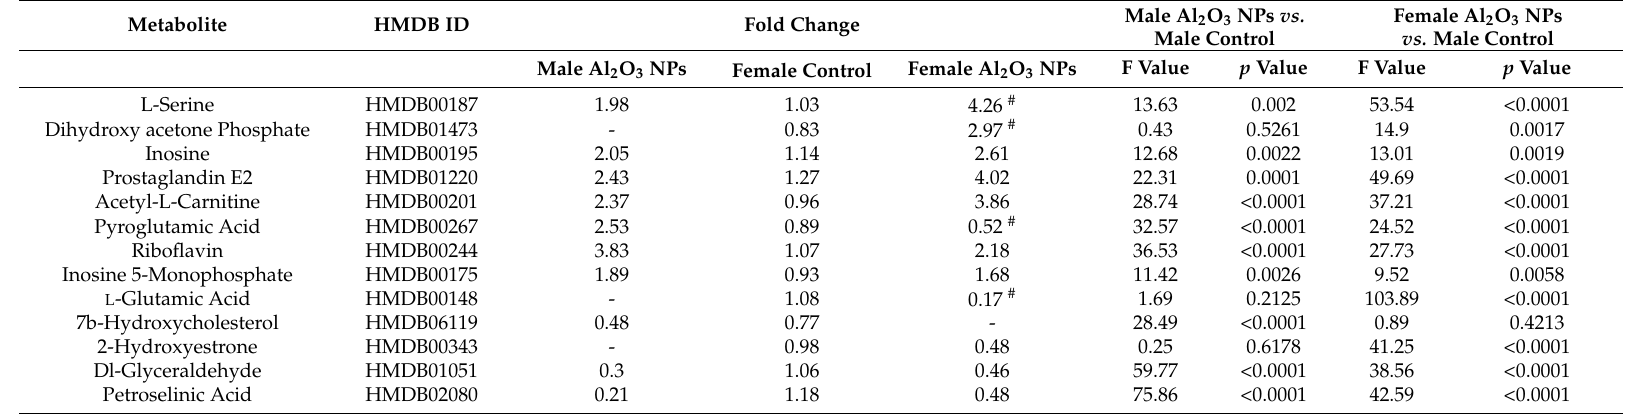
Table 3. Metabolomics analysis of Al 2 O 3 NP-treated mice